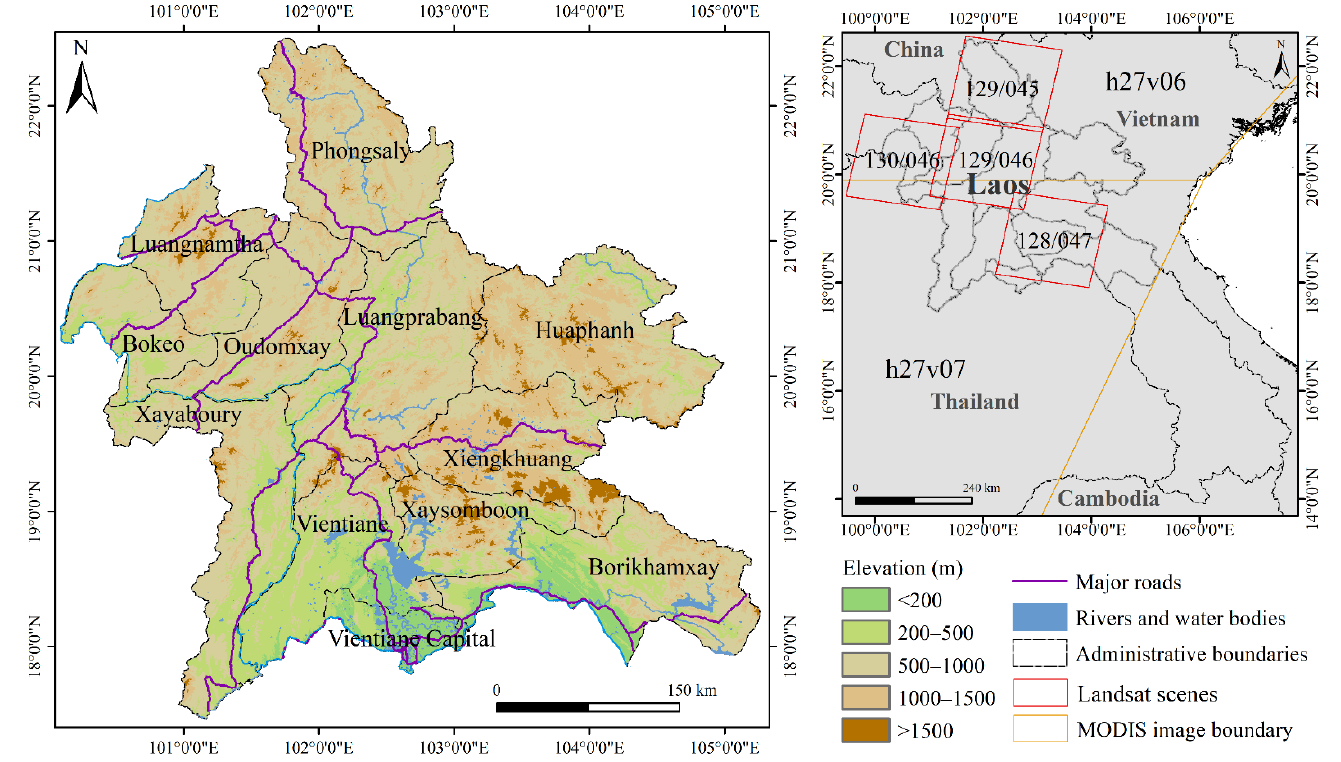
Figure 1. Maps showing the provinces, topography and footprints of Landsat and MODIS scenes of northern Laos.